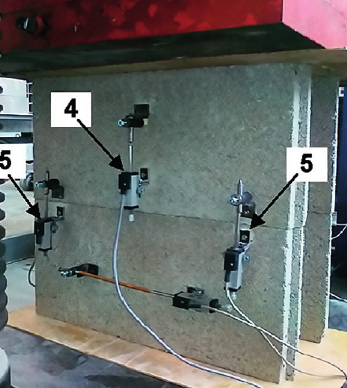
Fig. 4. Sample of a hollow block set in a “dry” manner, scheme of testing and measuring tool deployment